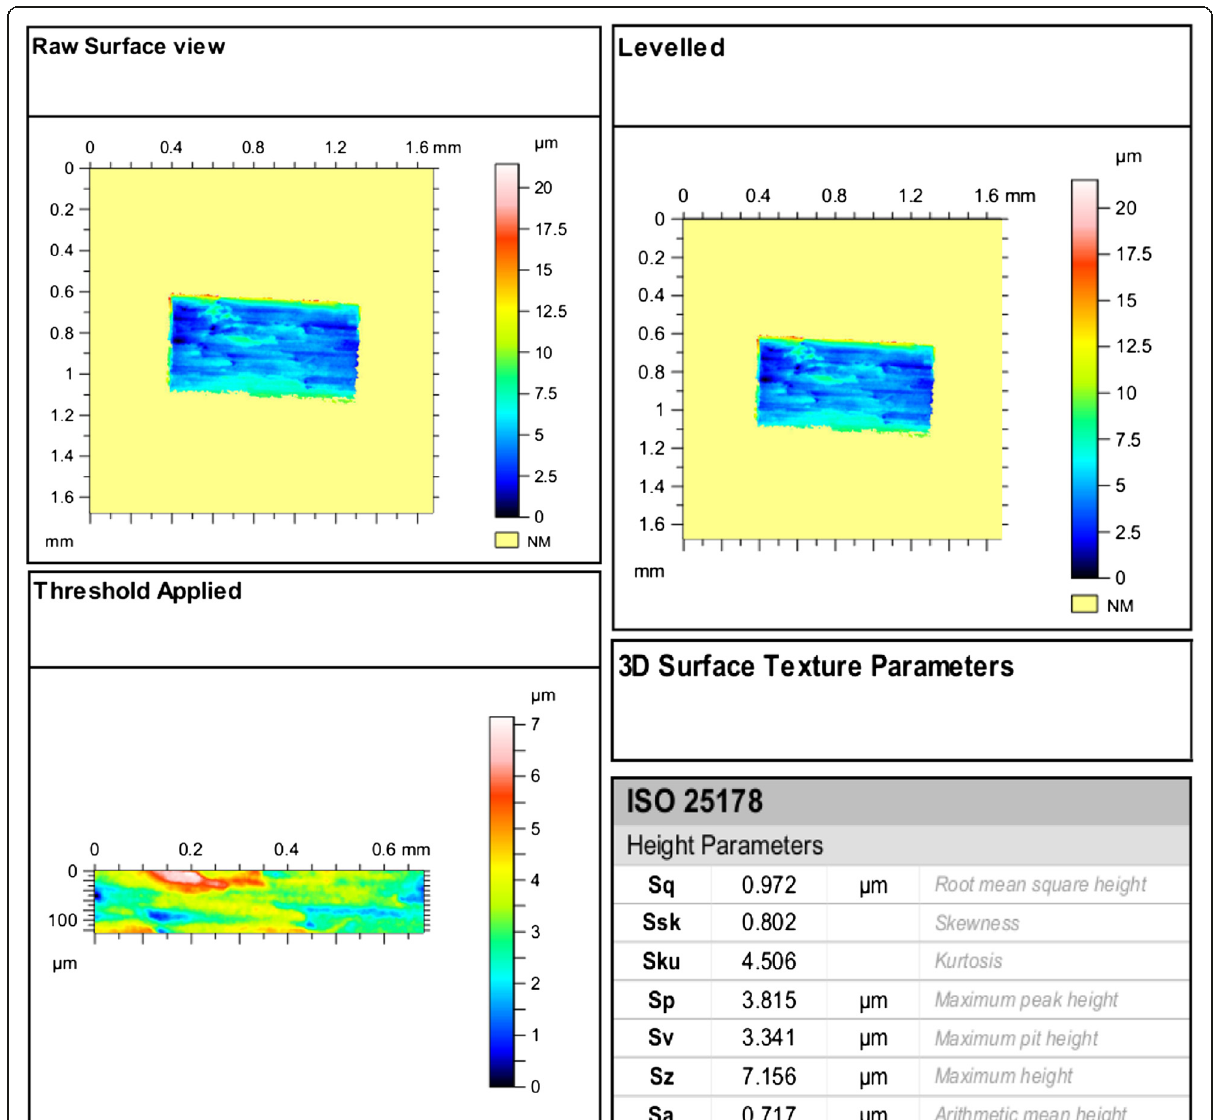
Fig. 6 Steps in recording the 3D surface texture parameters. a Raw surface view, b levelled surface. c Threshold applied. d . Surface